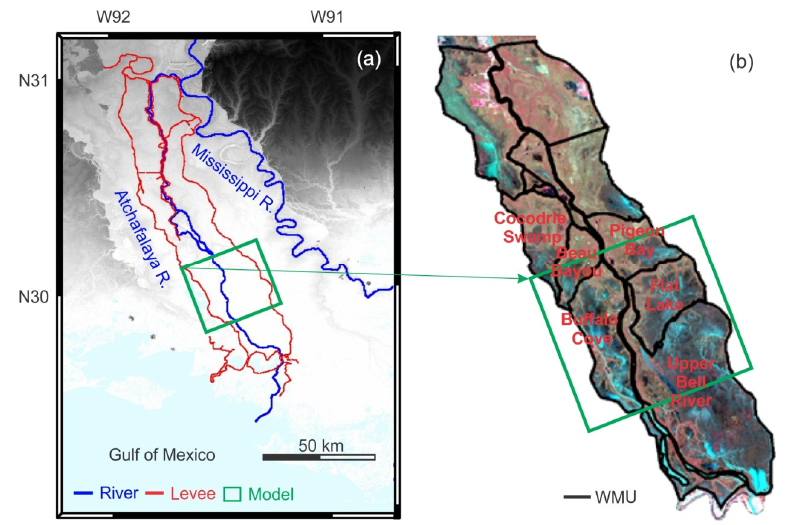
Figure 1. ( a ) LiDAR map over the study area. The Atchafalaya Basin is bounded on the east and west sides by levees in southern Louisiana. The Atchafalaya River and the Mississippi River are represented by blue lines. Levees are marked with red lines. The green rectangular box represents the model study area. ( b ) The Landsat ETM+ color composite image represents water management units (WMU) outlined by black lines, courtesy of